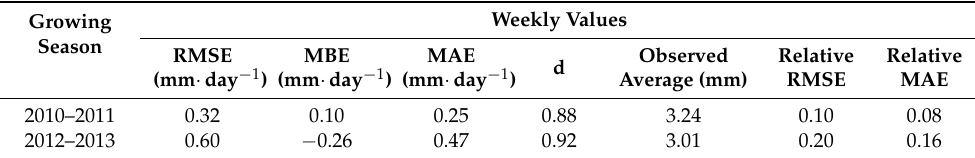
Table 4. Statistical measures for the comparison between the measured and modeled weekly crop evapotranspiration using the remote sensing-based water balance